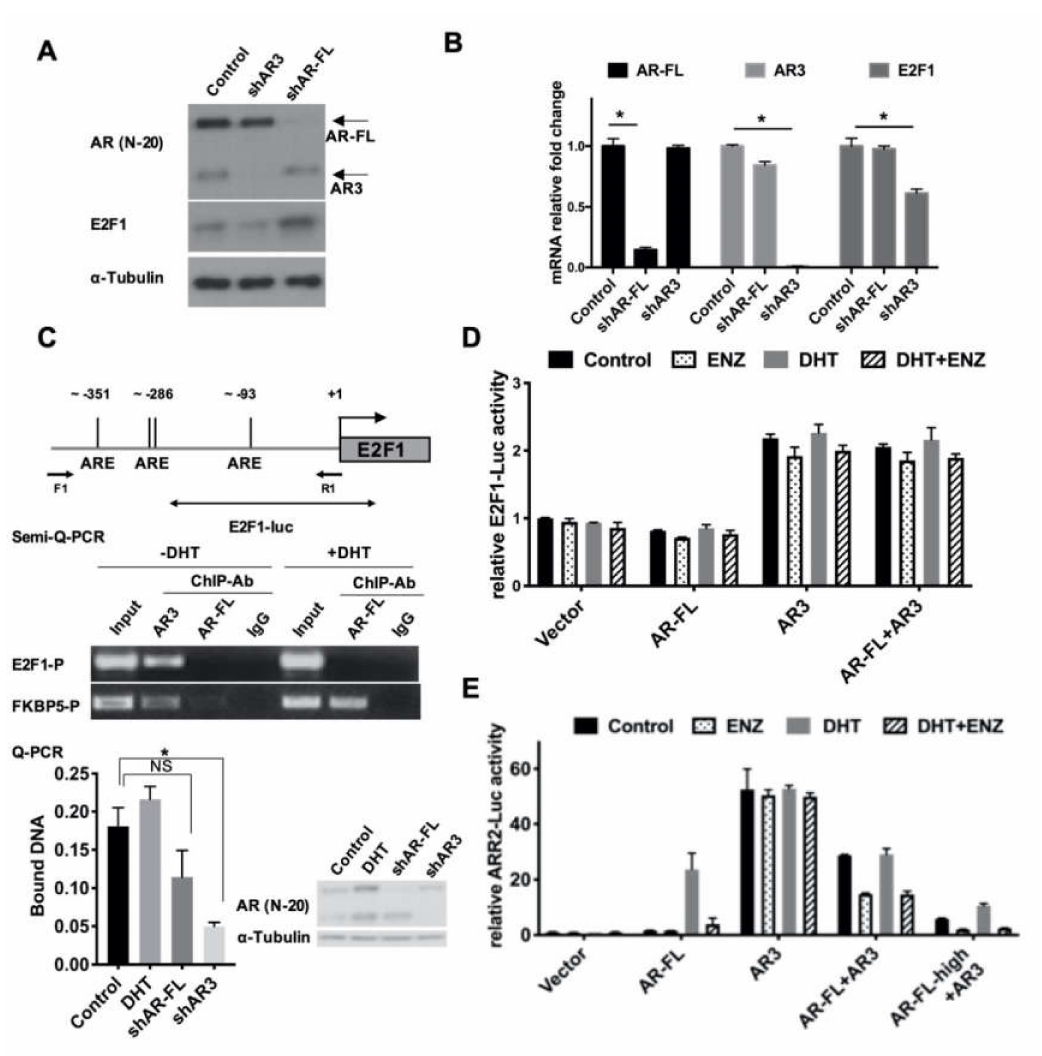
Figure 3. AR3 and AR-FL di ff erentially regulated E2F1 expression. ( A , B ) R1-ADR cells were infected with the lentivirus encoding the control shRNA, AR3 shRNA (shAR3) or AR-FL shRNA (shAR-FL) for 48 h. Protein levels of E2F1, AR-FL, and AR3 were determined by western blot ( A ) and mRNA levels were determined by qRT-PCR ( B ), Error bars, S.D. * p < 0.05. ( C ) Binding of AR3 or AR-FL to the putative ARE sites of human E2F1 gene regulatory region was analyzed by ChIP assays. Error bars, S.D. * p < 0.05. ( D ) The E2F1-promoter driven luciferase reporter (E2F1-LUC) activity was measured in HEK293T cells treated with 0.1nM DHT or / and 10 µ M ENZ. ( E ) ARR2-promoter luciferase assay was performed in HEK293T cells treated with 0.1nM DHT or / and 10 µ M